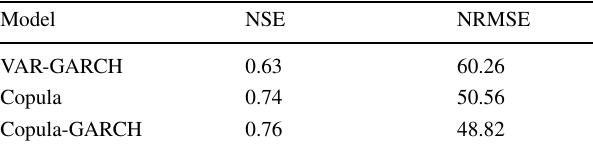
Table 3 Results of performance evaluation and error rate of the stud- ied models using NSE and NRMSE statistics